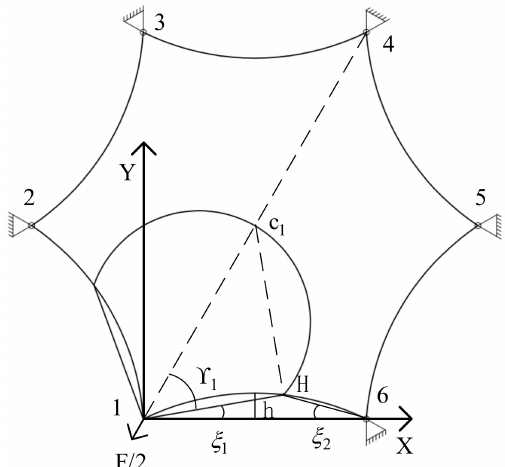
Figure 7. c 1 nodal stress